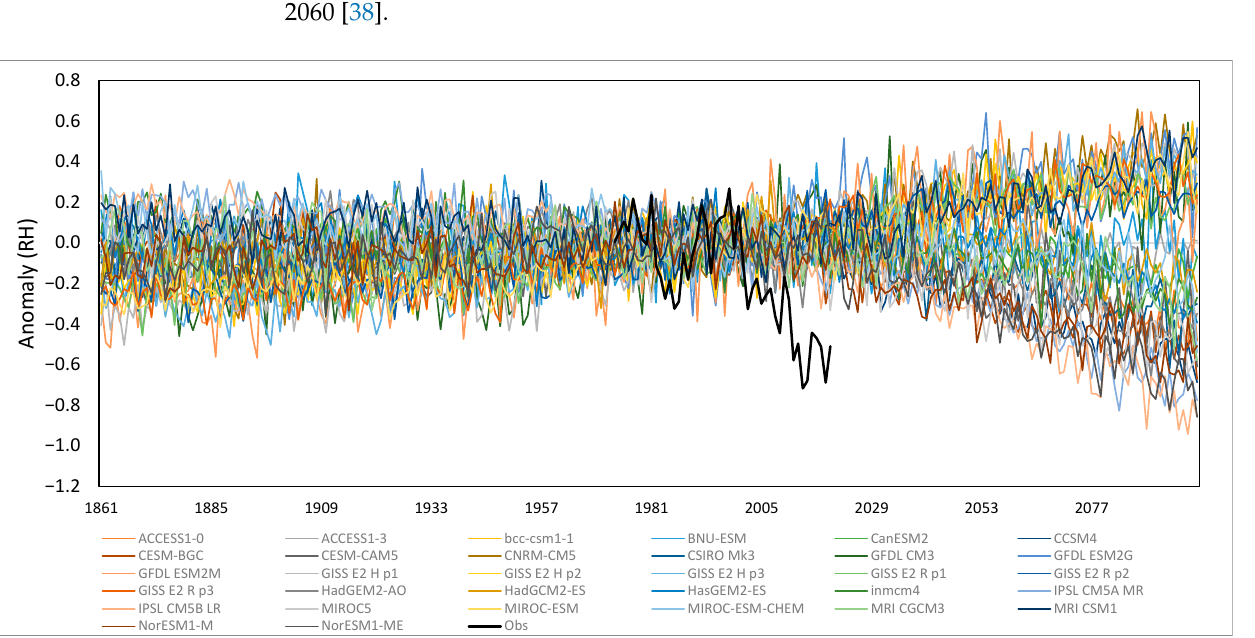
Figure 5. Simulated annual RH 70° S to 70° N from CMIP5 RCP4.5 (1861–2100) with a baseline of 1981–2010 compared with observed RH for blended global RH from Had ISDH (1973–2020). Observations have been adjusted by − 0.10.